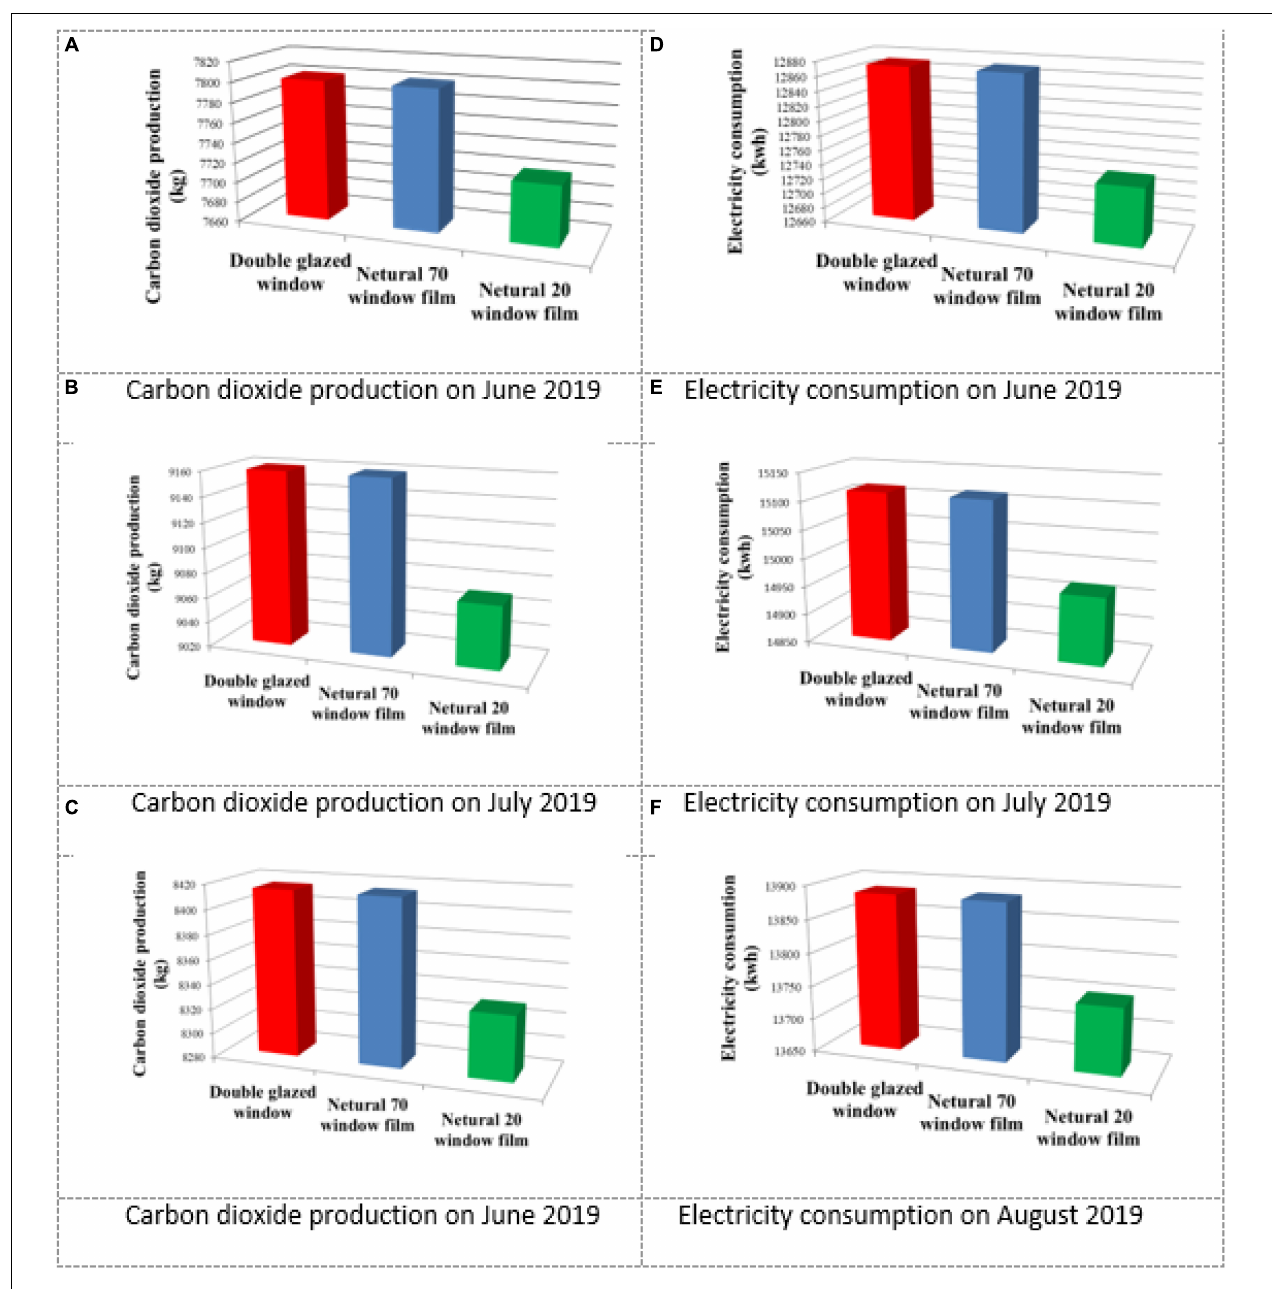
FIGURE 14 | Comparison of carbon dioxide production and electricity consumption of four offices in the ACK building using double-glazed windows with/without 3M Neutral 70 and 3M Neutral 20 window films in summer 2019 in Kuwait. (A) CO 2 production on June 2019. (B) CO 2 production on July 2019. (C) CO 2 production on August 2019. (D) Electricity consumption on June 2019. (E) Electricity consumption on July 2019. (F) Electricity consumption on August